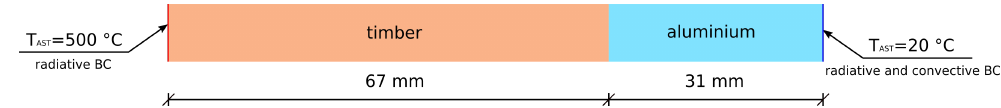
Figure 10. Experiment setup according to